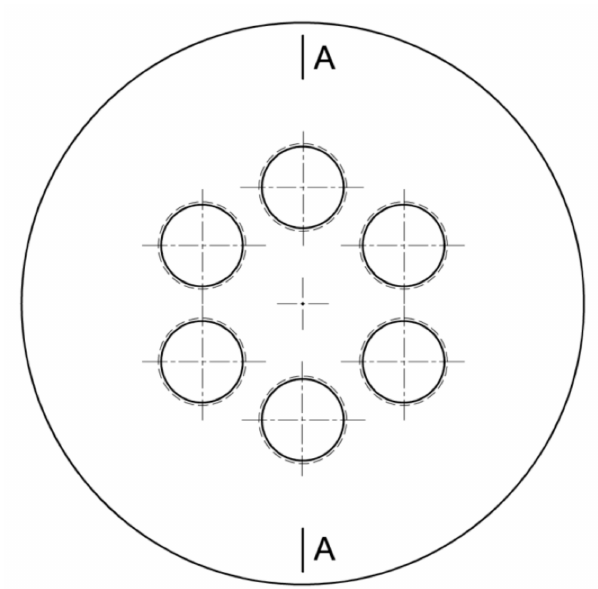
Figure 2. Front view of the multi-hole orifice.